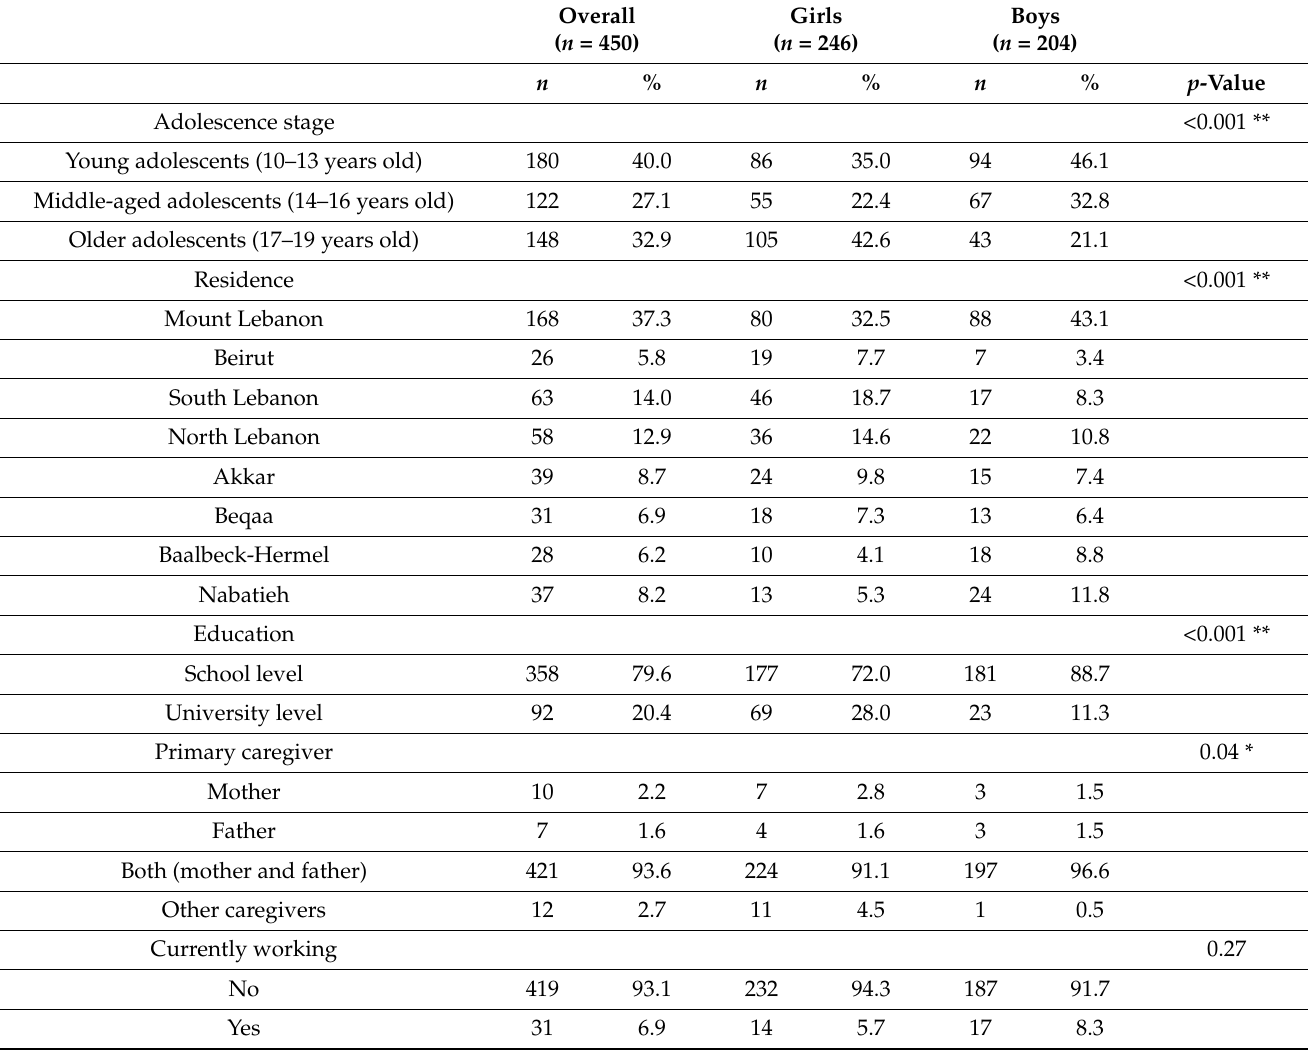
Table 1. Adolescents’ general